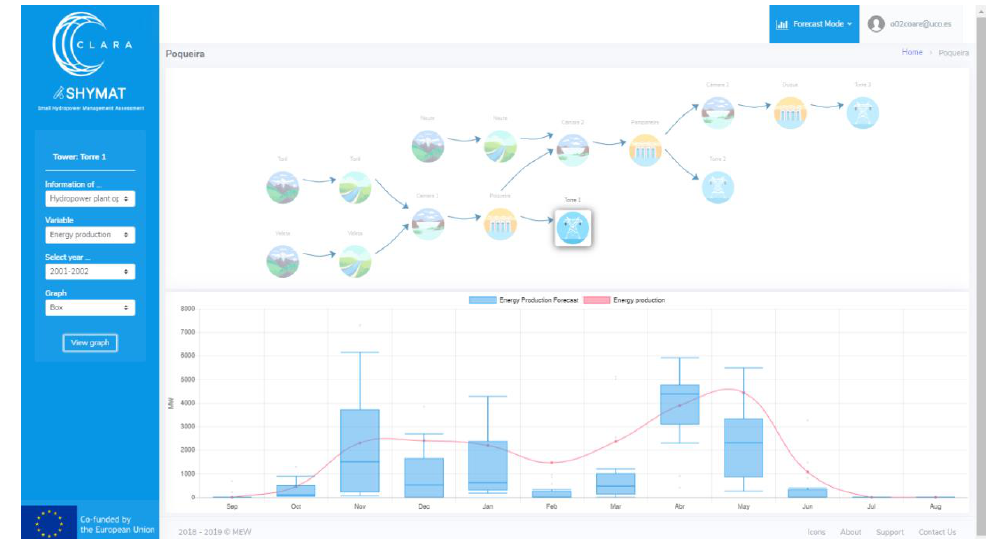
Figure 8. Example of the visualization of the SHYMAT web user interface. Forecast mode outputs: The power gridelement is selected in the topology panel and a graph showing monthly values of the energy production expected for the next seven months (boxplot) and real energy production (line) appears on the screen.